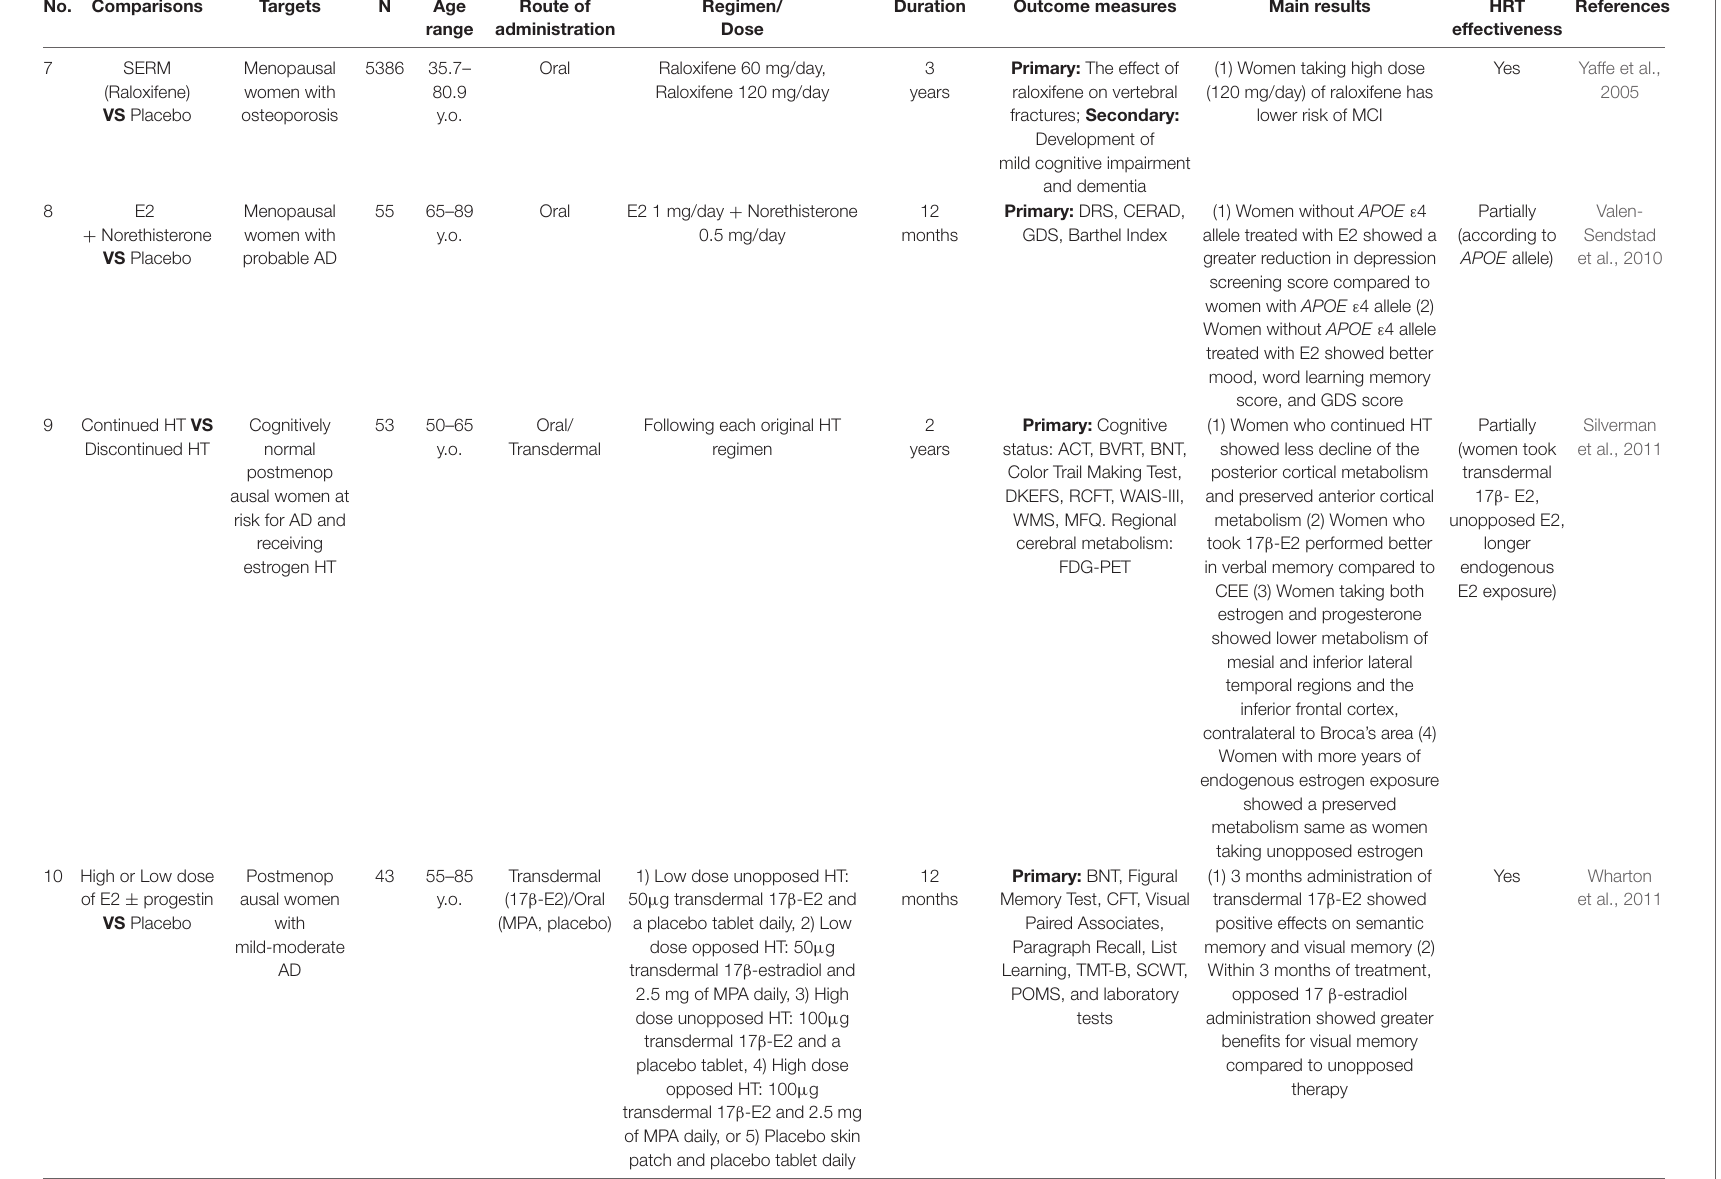
Primary: BNT, Figural Memory Test, CFT,